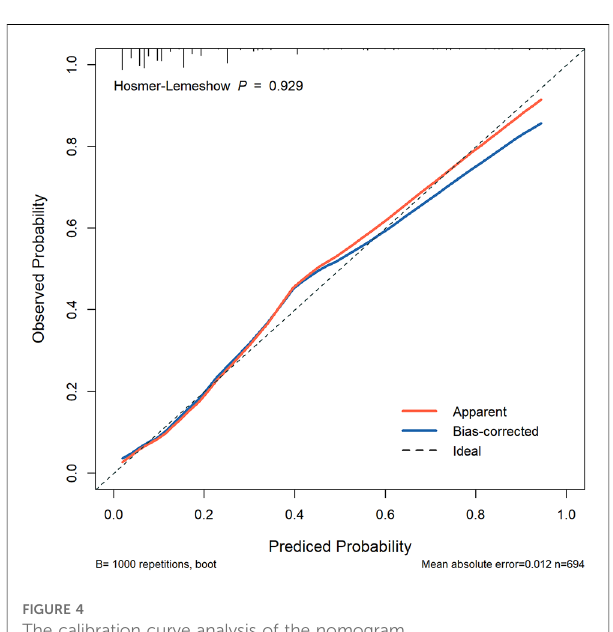
FIGURE 4 The calibration curve analysis of the